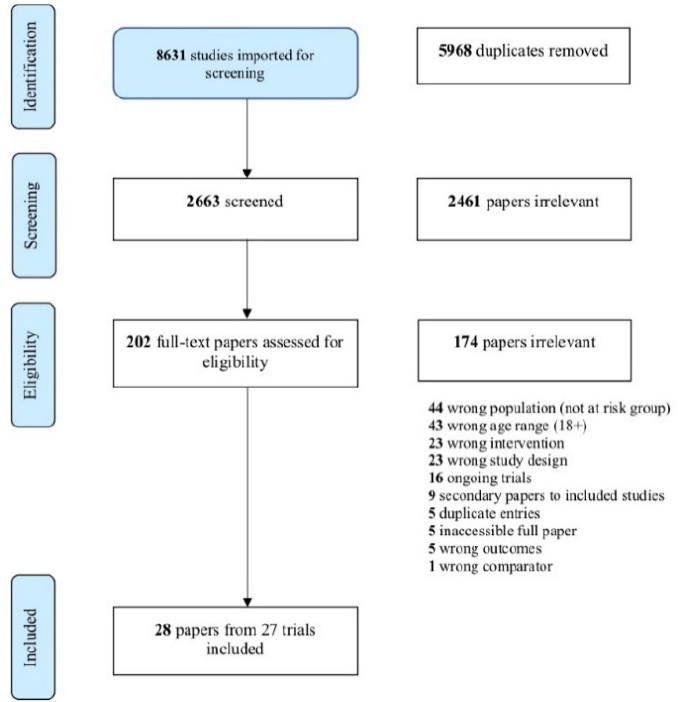
Figure 1. PRISMA flow diagram of included studies.